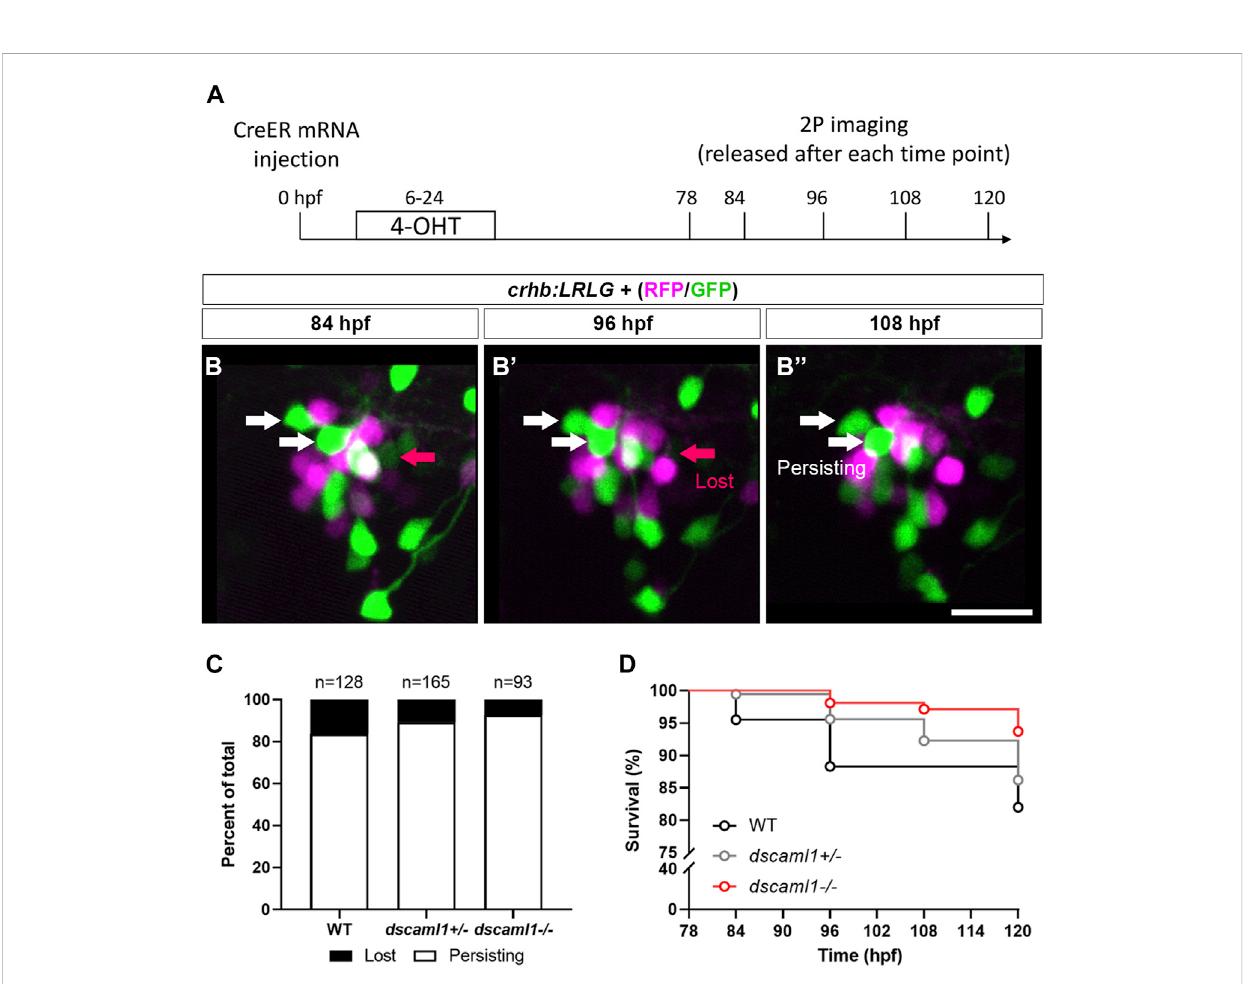
Live tracking of CRH NPO neuron cell fate. (A) Timeline of time-lapse two-photon (2P) imaging experiment. Partial recombination of crhb:LRLG was inducedby4-OHTat6 – 24hpf,andimagingwasperformedat78,84,96,108,and120hpf.Animalswerebrie fl yanesthetizedduringimagingandallowed torecoverinbetweenimagingsessions. (B – B ” ) TrackingofindividualCRH NPO neurons.Threeexampletimeframesareshown.Individual fl uorescentcells canbetrackedovertimeandaredividedintotwocategories:persisting(whitearrows)orlost(pinkarrow).Thescalebaris20 μ m. (C) Quanti fi cation of the percentage of persisting versus lost CRH NPO neurons. Sample size (cell number) as indicated for each genotype. (D) Survival curve of individual CRH NPO neurons in each genotypic group.